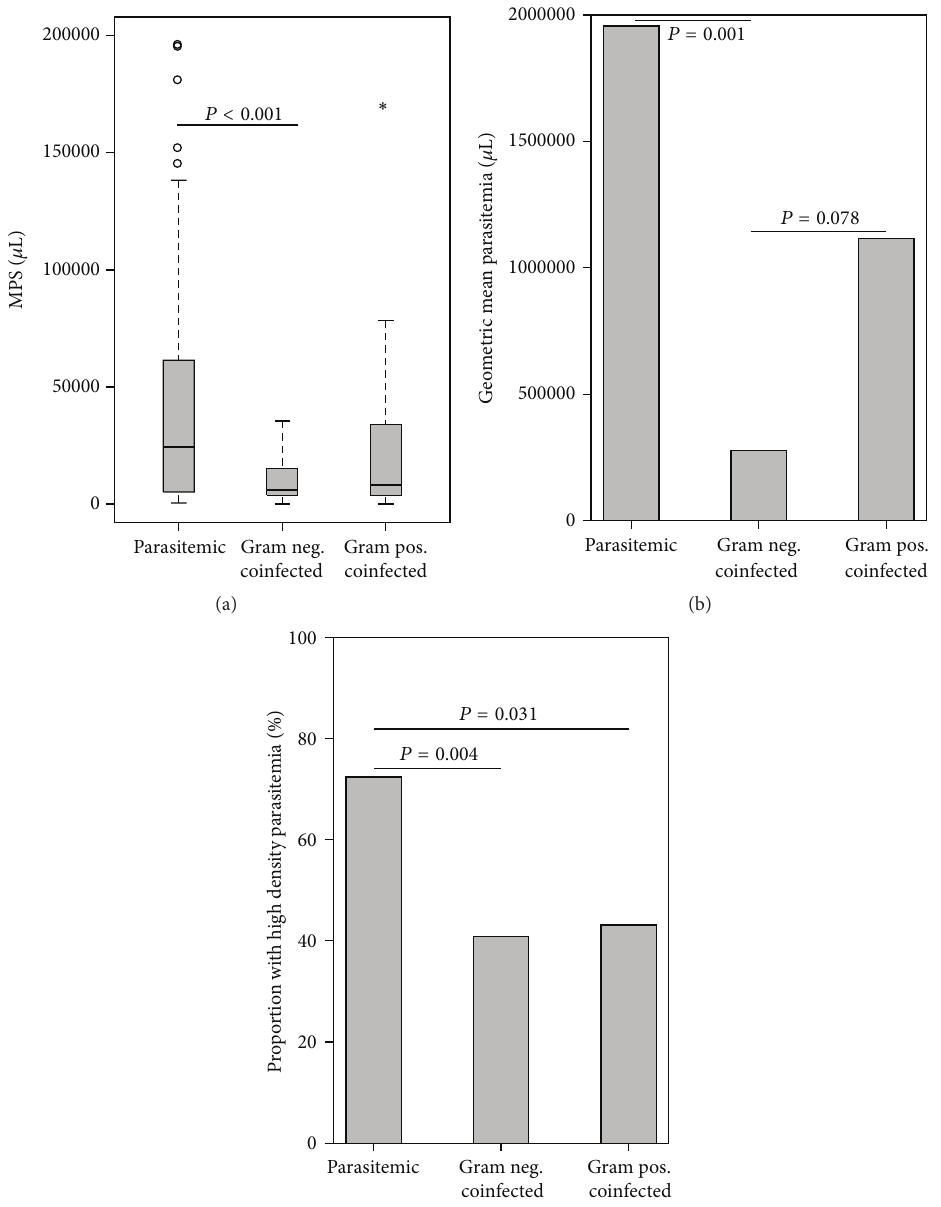
Figure 1: Parasitologic indices. Data are presented as box plots with whiskers and outliers. The box represents the interquartile range, while the whiskers represent the 10th and 90th percentiles. The line across the box indicates the median value, open circles ( ∘ ) represent extremes, and asterisks ( ∗ ) depict outliers. Differences between groups were determined using Mann-Whitney 𝑈 test. (a) MPS [malaria parasites] (Kruskal-Wallis [K-W] test, 𝑃 = 0.001 ). (b) Geometric mean parasitemia (ANOVA, 𝑃 = 0.011 ). (c) Proportion of high-density parasitemia (%) (K-W test, 𝑃 = 0.002